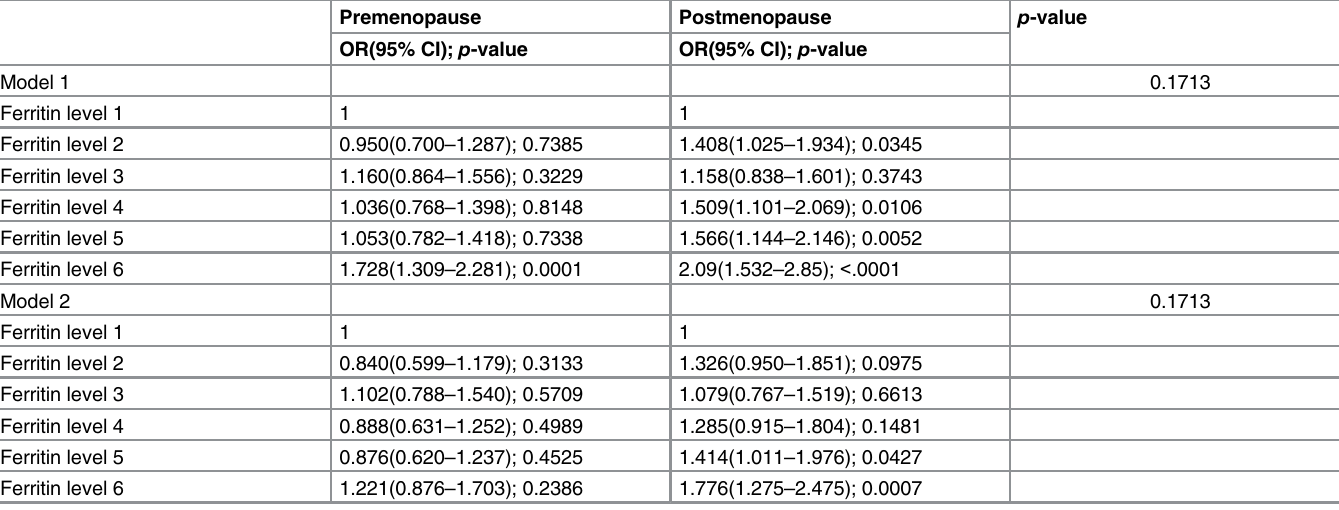
Table 4. Adjusted odds ratios (95% confidence interval) for WC ( (cid:1) 85 cm) by serum ferritin